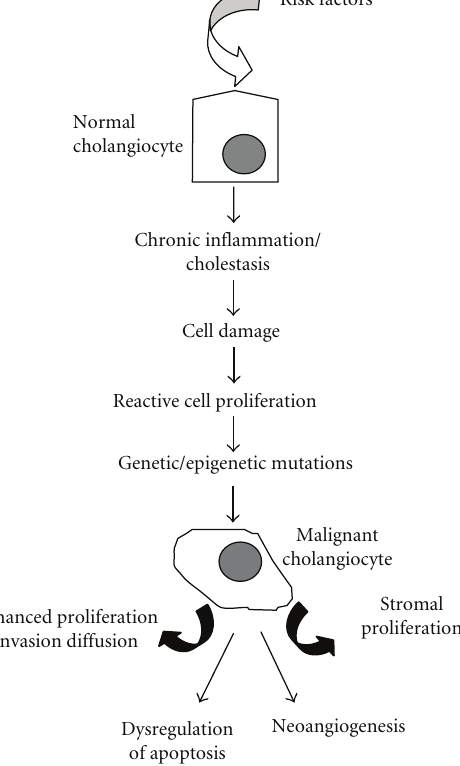
Figure 1: Proposed mechanisms leading to transformation of normal biliary cells into malignant cholangiocytes. Cholangiocar- cinoma cells express altered molecular mechanisms, which enhance cell proliferation, decrease apoptosis, and increase the capacity of tissue invasion, stromal proliferation, and